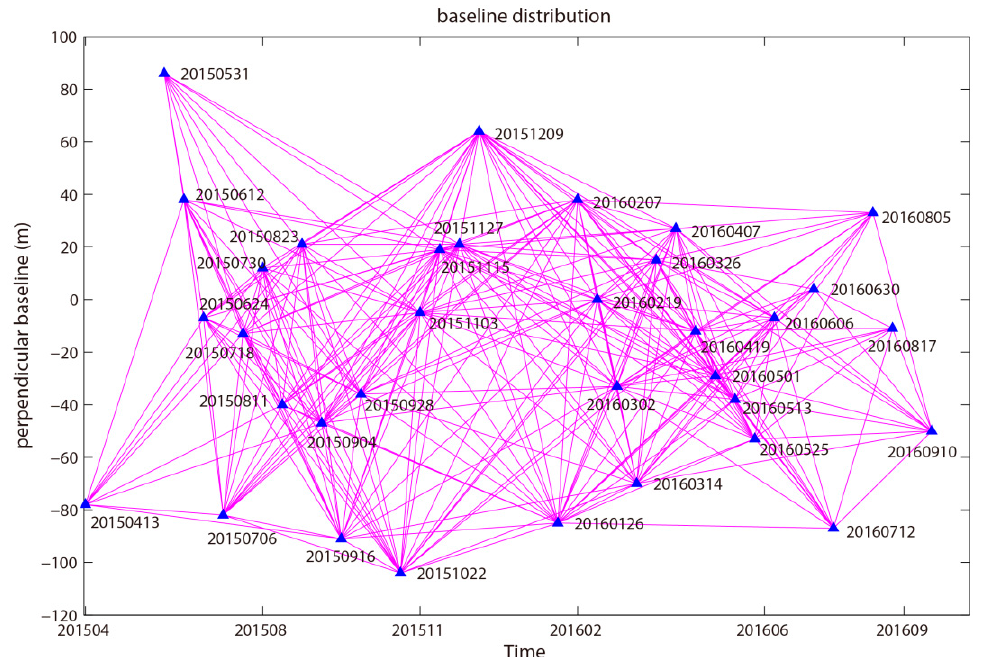
Figure 3. The baseline distribution of the interferograms, where the blue triangles show the times of the SLC image acquisitions and the purple lines display the formed interferograms.